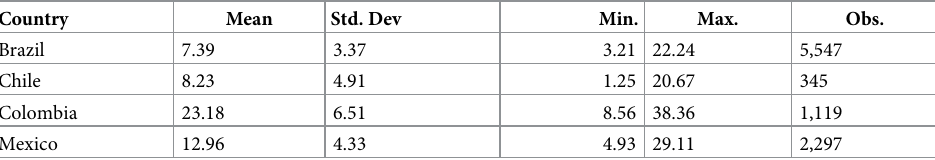
Table 2. Descriptive statistics on 2000–2018 fine particulate matter (PM 2.5 ) concentrations.